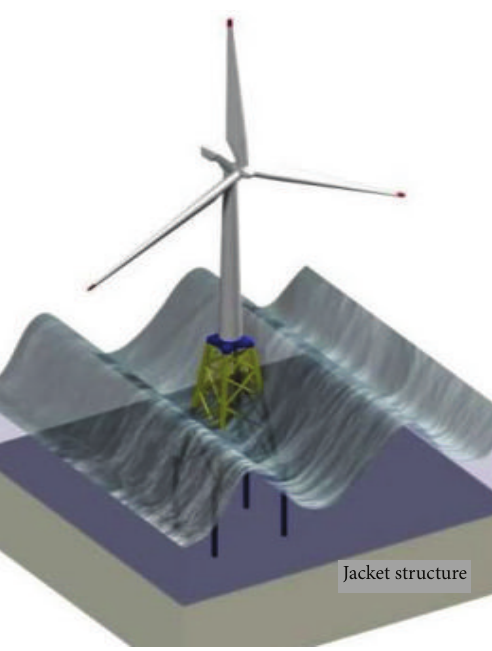
Figure 3: Jacket structure